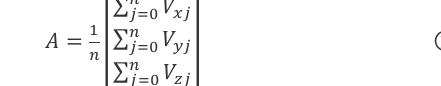
Figure 1. Flow chart of the pipeline of the Entertainment